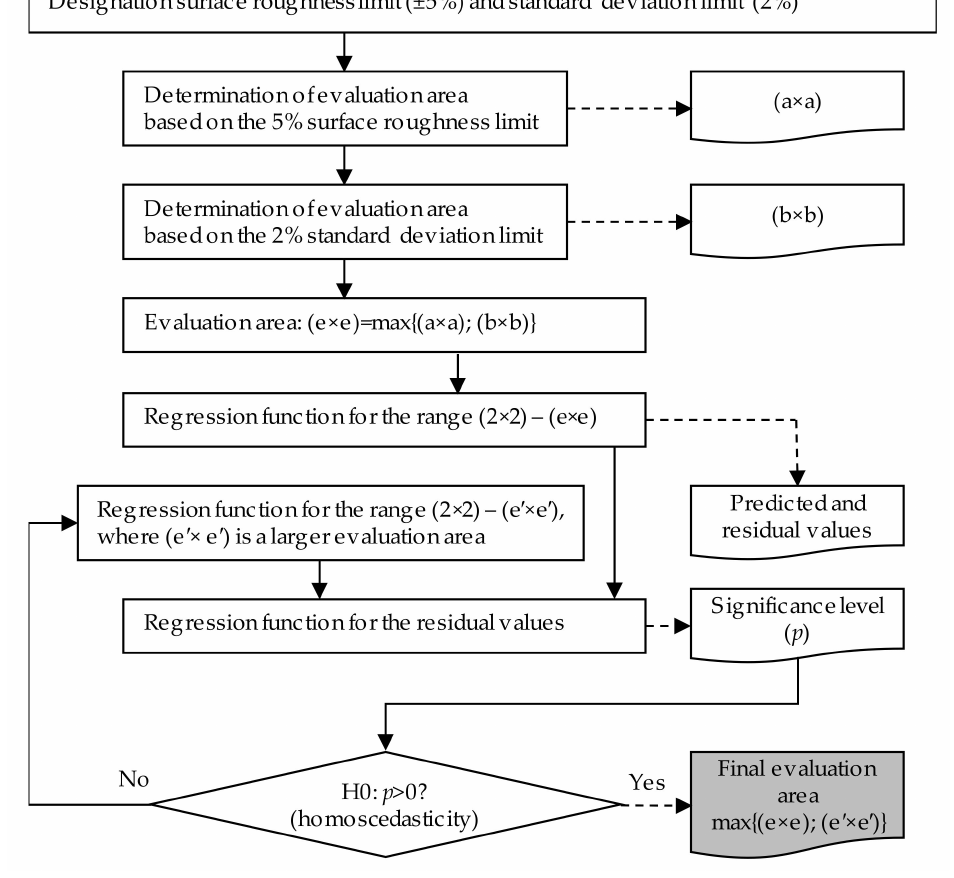
Figure 3. Process of the minimization of the evaluation